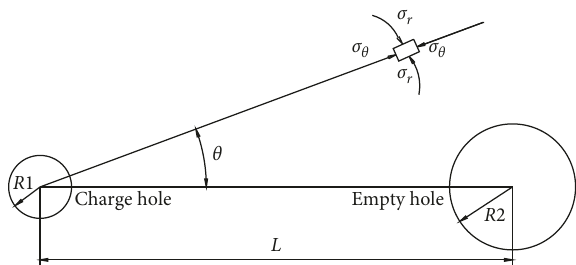
Figure 1: Analysis of stress concentration effect of voids.